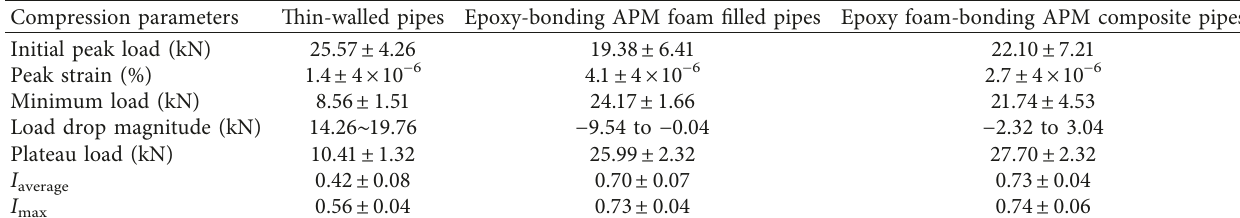
Figure 9: Load-strain curves of (a) thin-walled pipes, (b) epoxy-bonding APM composite pipes, (c) and epoxy foam-bonding APM composite Table 2: Compression characteristic parameters of different specimens.